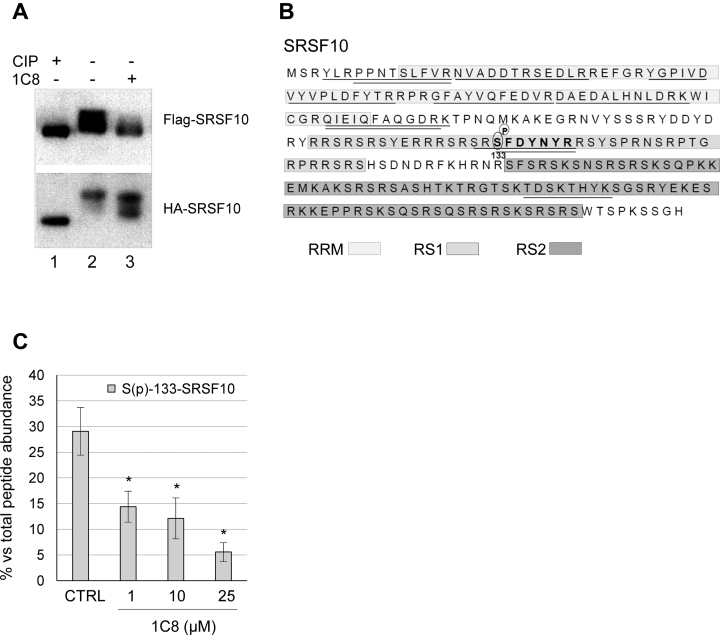
1C8 affects the phosphorylation of SRSF10. (A) Total cellular extracts of HeLa-HIV cells transfected with Flag-SRSF10 or HA-SRSF10 expression plasmids were prepared 24 h after treatment or not with 20 μM of 1C8. Aliquots of extract from untreated cells were incubated with or without calf intestinal phosphatase (CIP) for 15 min at 37°C. Extracts were fractionated on a denaturing gel and proteins were transferred on nitrocellulose to reveal tagged SRSF10. (B) Amino acid sequence of the SRSF10-1 protein showing the different domains (RRM, RS1 and RS2) in shaded boxes. The SRSF10 peptides identified by LC–MS/MS analysis after immunoprecipitation of cellular extracts with the anti-Flag antibody are underlined, while the SFDYNYR peptide which carries a phosphorylated serine at position 133 is shown in bold. (C) The percentage of phosphorylated SFDYNYR relative to the non-phosphorylated version recovered from HeLa-HIV cells treated with the indicated doses of 1C8 is plotted. Asterisks represent P values (two-tailed Student's t test) comparing the means between 1C8-treated samples and the control; *P < 0.05, **P < 0.01 and ***P < 0.001.